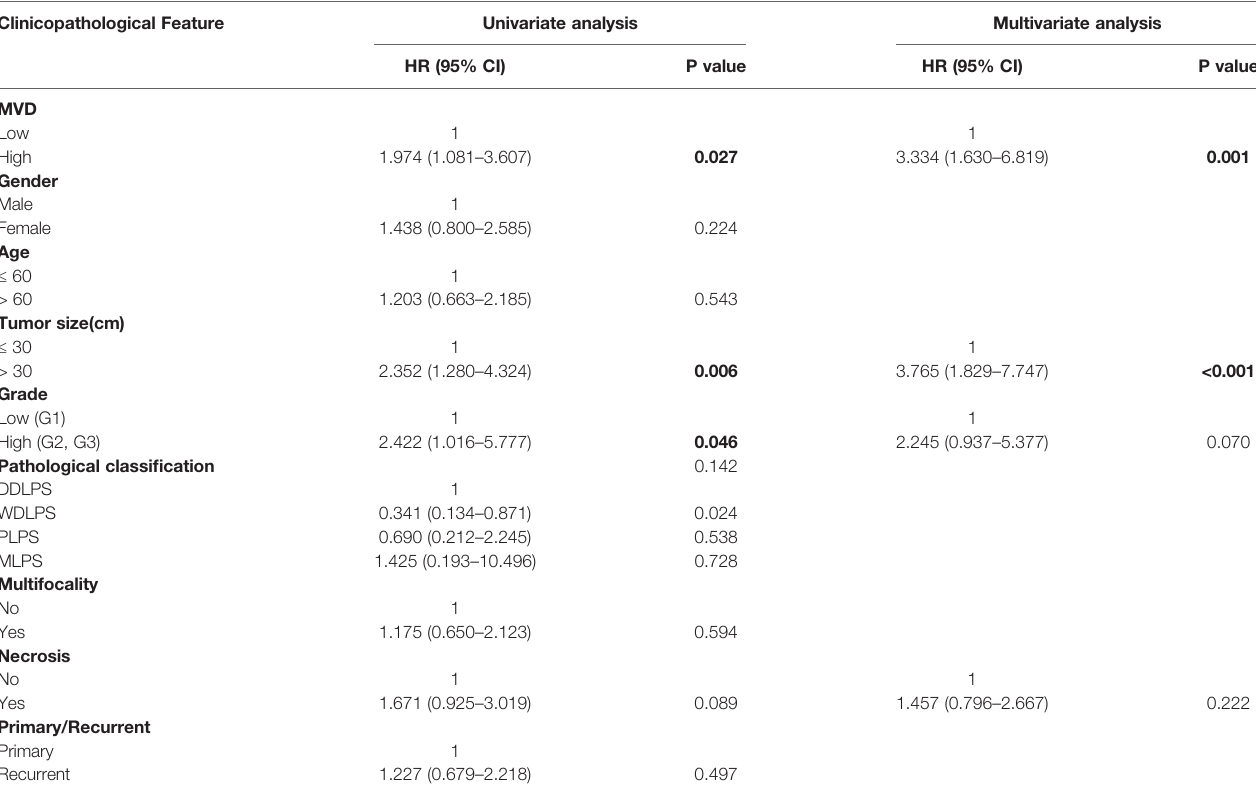
TABLE 2 | Univariate and multivariate analyses of independent risk factors for OS in retroperitoneal liposarcoma